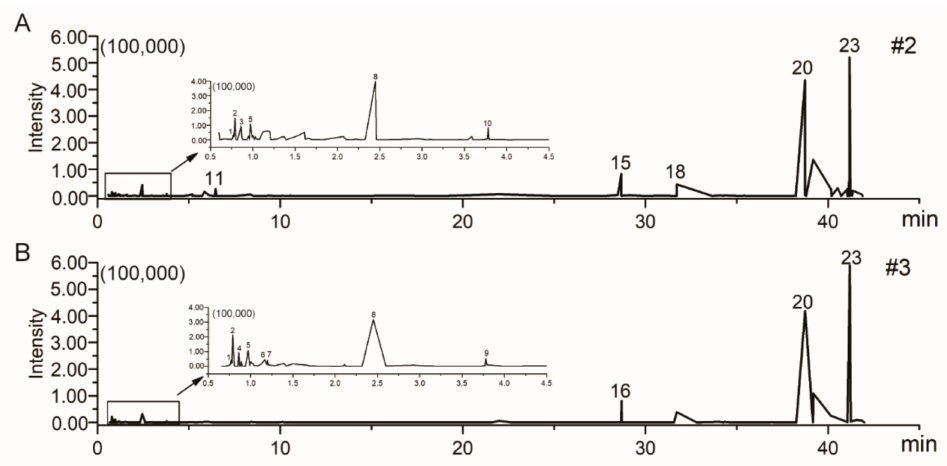
Figure 5. The total ion chromatogram (TIC) of UFLC-Q-TOF-MS/MS obtained from #2 ( A ) and #3 ( B ) in the positive-ion